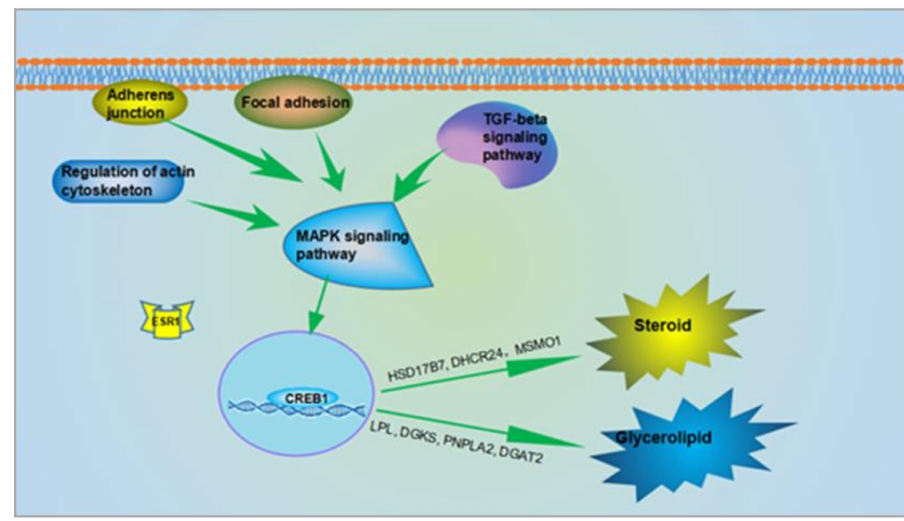
Figure 6. The potential regulatory network mediating lipid deposition in ovariectomized chickens. The AF deposition regulatory network may include: Glycerolipid metabolism, steroid metabolism, MAPK, TGF- β , and cell junctions (cell adhesion, adherens junctions, regulation of actin cytoskeleton)